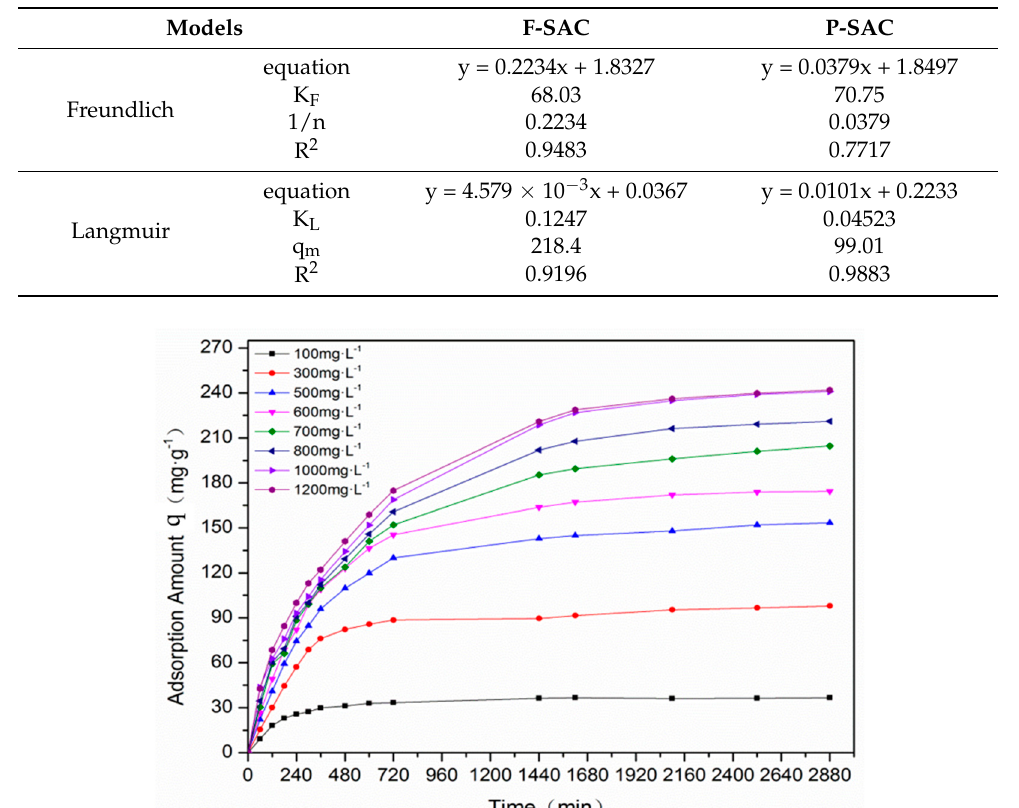
Figure 7. The effect of the initial EBT concentration on the adsorption of EBT by F-SAC.